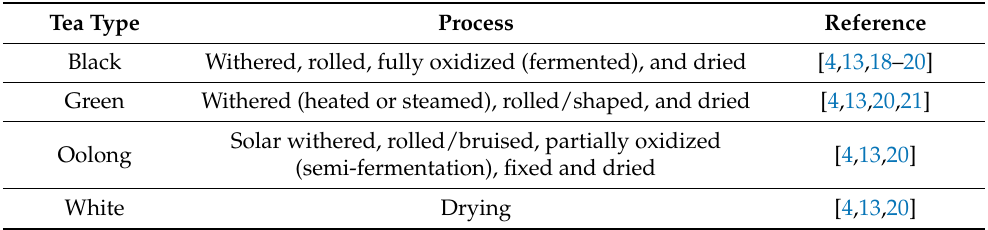
Table 1. Processing methods for different types of tea used to brew kombucha. Tea Type Process Reference Black Withered, rolled, fully oxidized (fermented), and dried [4,13,18–20] Green Withered (heated or steamed), rolled/shaped, and dried [4,13,20,21] Solar withered, rolled/bruised, partially oxidized Oolong [4,13,20] (semi-fermentation), fixed and dried White Drying